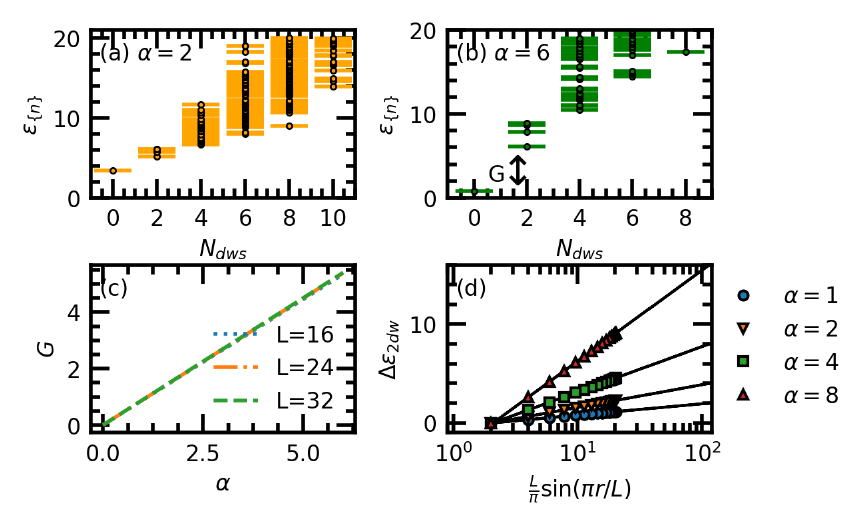
Figure 1: (a,b) The participation spectrum ε ( { n } ) for α = 2,6 and L = 16. The spectrum is indexed using the number of domain walls configurations N participation gap G increases linearly with α , with a coefficient that saturates to a constant g ∞ already at modest system sizes. (d) Pseudo-energy differences between two domain walls as a function of the domain-wall separation r . This is a measure of the confining potential between domain walls. The black solid line is the Luttinger liquid prediction [ 60 ] with Luttinger parameter K = 1 /α . The fit describe extremely well our data, for 4 ≤ L ≤